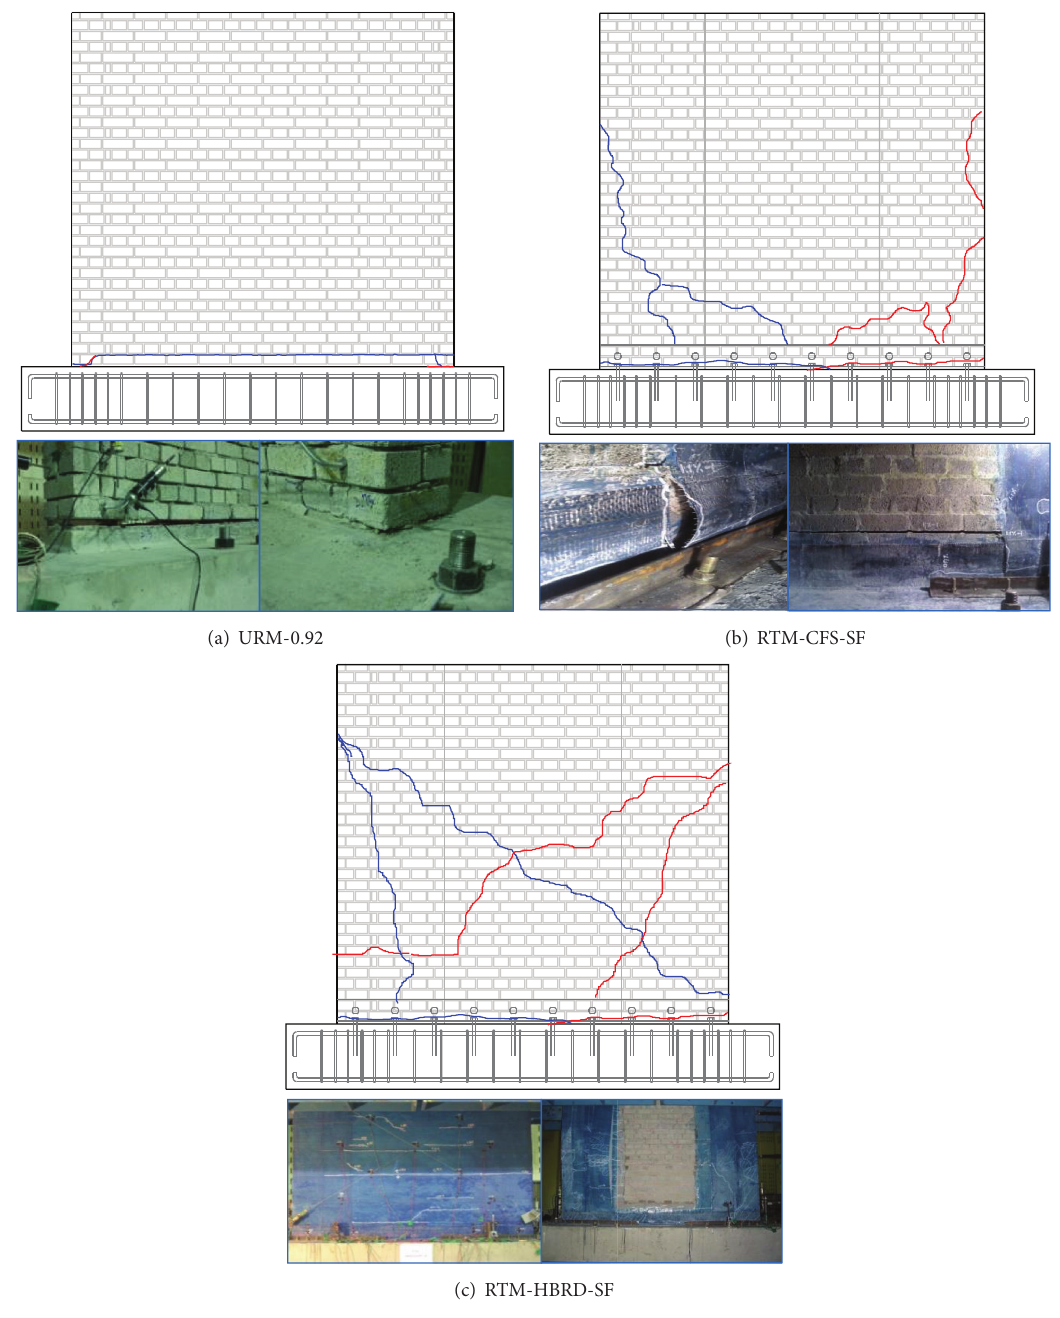
Figure 7: Crack pattern and failure mode. Table 6: Evaluation of proposed